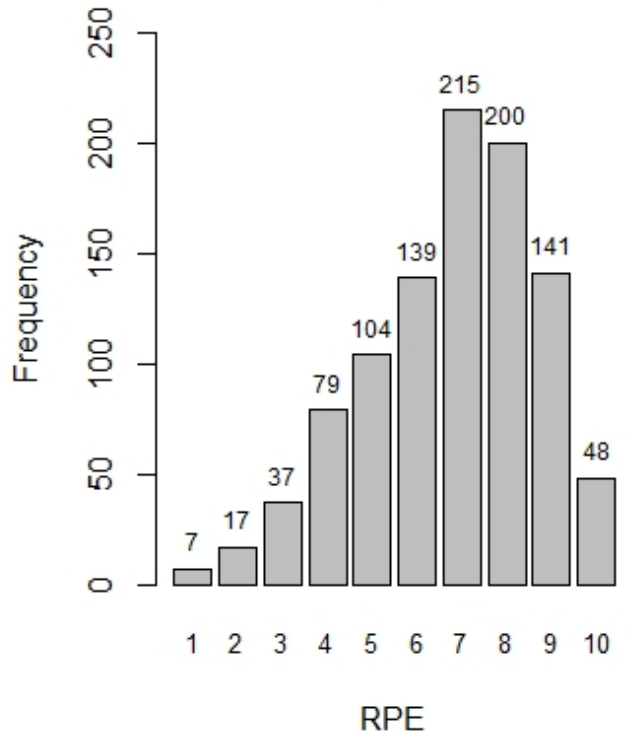
Figure 1. Frequency of athlete self-reported RPE values.